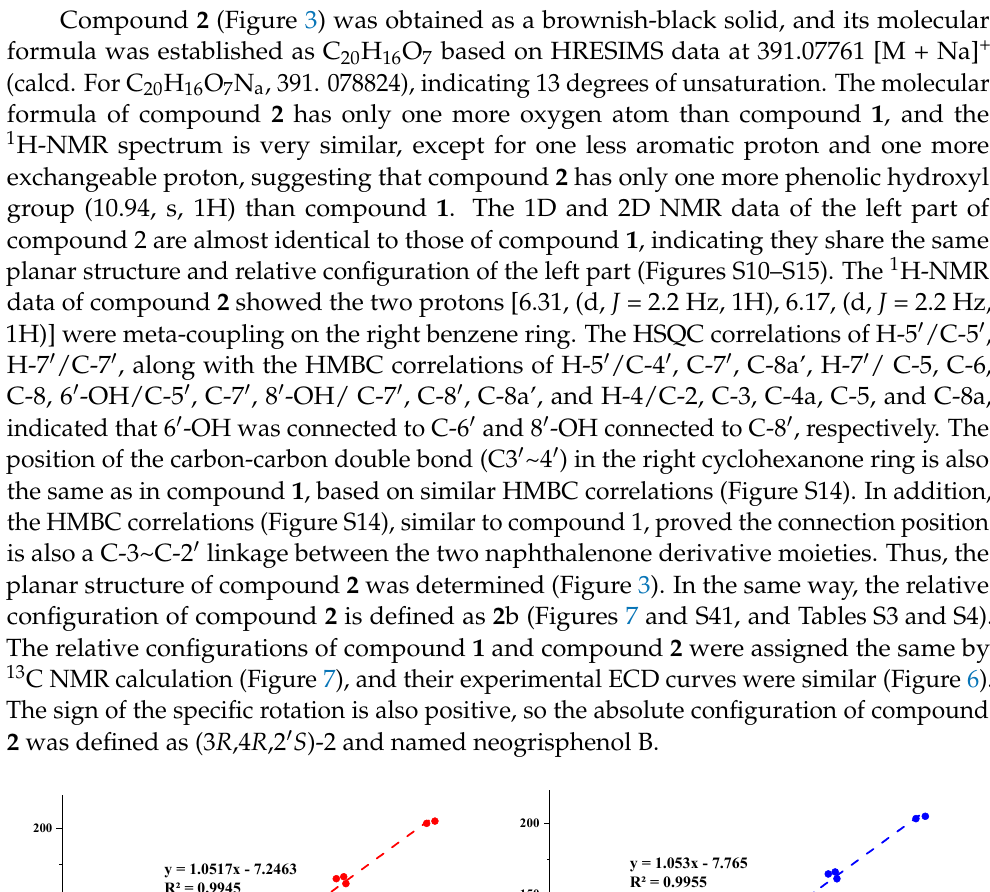
Figure 6. Calculated and experimental ECD spectra of compounds 1 and 2 .